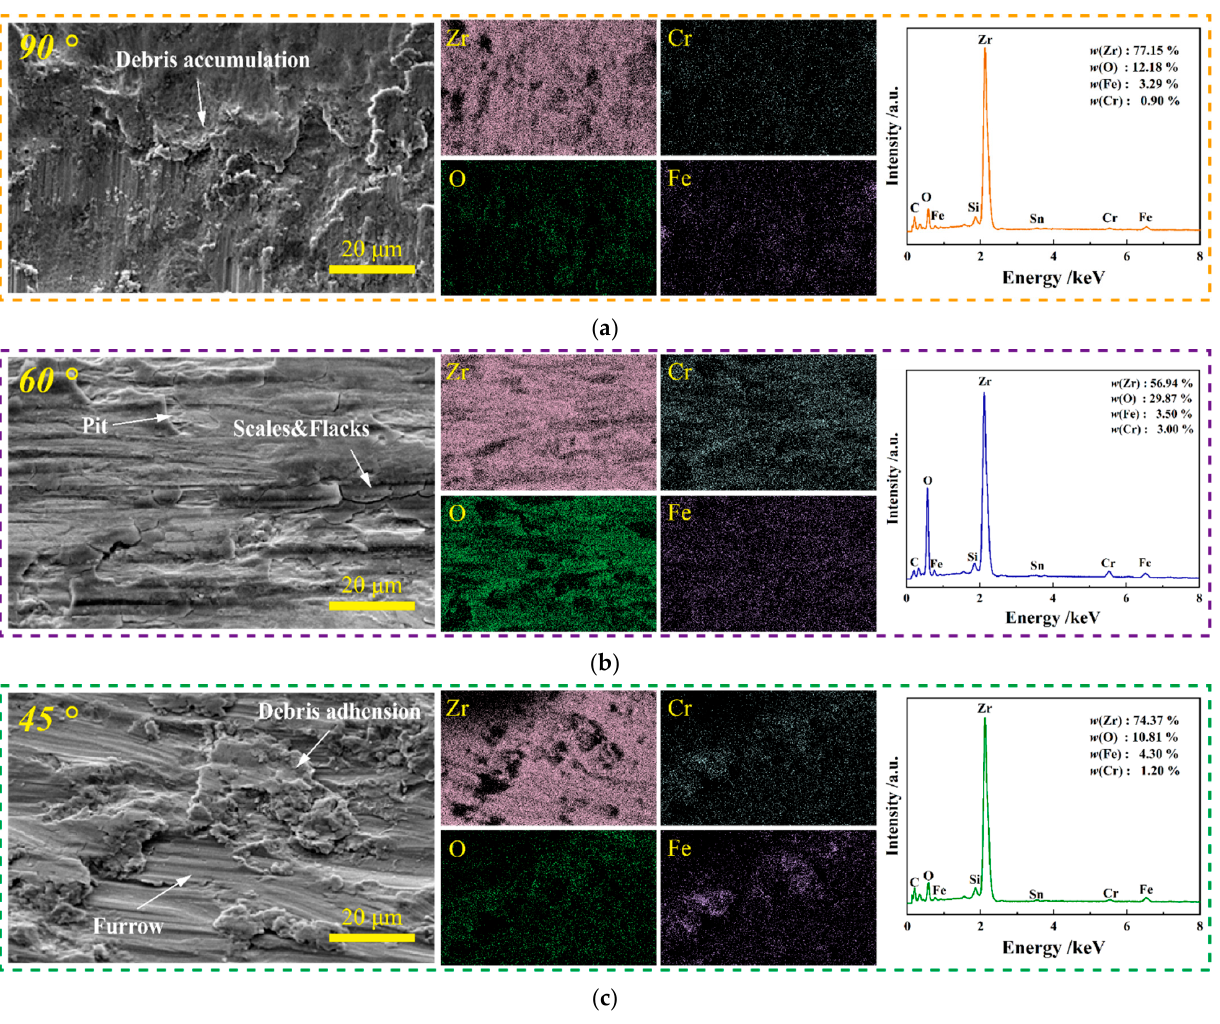
Figure 14. SEM morphology and element distribution of wear debris on the surface of wear scar at different impact angles. ( a ) θ = 90°; ( b ) θ = 60°; ( c ) θ = 45°.